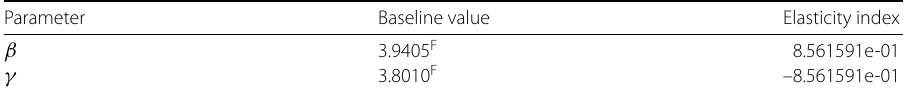
Table 2 The elasticity indices for R 0 = 1.0313 to the parameters of model (5) Parameter Baseline value Elasticity index